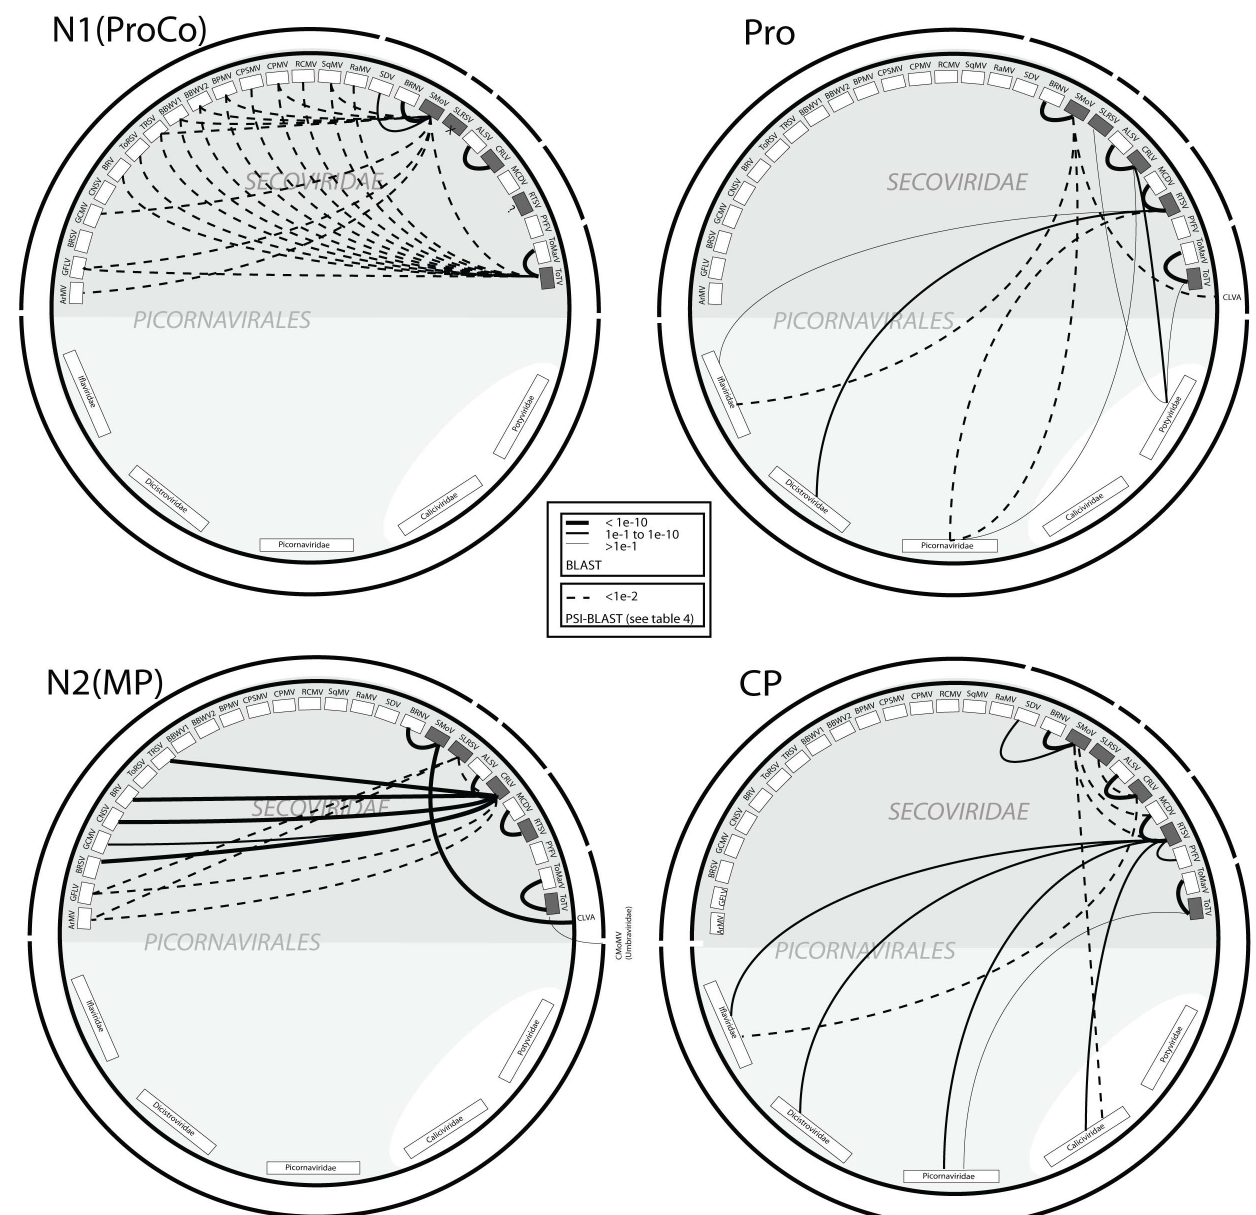
Figure 5. Schematics of the amino acid similarities four functional domains of members of the Secoviridae . These proteins are: on RNA1 (a), the putative protease cofactor or 1N terminal protein 1N(ProCo), the protease (Pro), and on RNA2 (b) the putative movement protein or 2N terminal protein 2N(MP), and the coat protein (CP). The analyzed proteins are those from five lineages of secovirids, the species Apple latent spherical virus (ALSV), Arabis mosaic virus (ArMV), Bean pod mottle virus (BPMV), Beet ringspot virus (BRSV), Black raspberry necrosis virus (BRNV), Blackcurrant reversion virus (BRV), Broad bean wilt virus-1 (BBWV1), Broad bean wilt virus-2 (BBWV2), Cherry rasp leaf virus (CRLV), Cowpea mosaic virus (CPMV), Cowpea severe mosaic virus (CPSMV), Cycas necrotic stunt virus (CNSV), Grapevine chrome mosaic (GCMV), Grapevine fanleaf virus (GFLV), Maize chlorotic dwarf virus (MCDV), Parsnip yellow fleck virus (PYFV), Radish mosaic virus (RaMV), Red clover mottle virus (RCMV), Rice tungro spherical virus (RTSV), Satsuma dwarf virus (SDV), Squash mosaic virus ( SqMV), Strawberry mottle virus (SMoV), Strawberry latent ringspot virus (SLRSV), Tobacco ringspot virus (TRSV), Tomato marchitez virus (ToMarV) and Tomato ringspot virus (ToRSV), Tomato torrado virus (ToTV). In the lower light gray shaded hemisphere are the animal infecting families of the order Picornavirales, which excludes the picorna-like virus families Caliciviridae and Potyviridae. The outer broken black circle shows the clustering of related viruses in different secovirus lineages. Similarities were determined using the BLAST and PSI-BLAST algorithms; details of the PSI-BLAST are listed in table 4. Viruses depicted were selected based on the highest scoring sequence for each species (within the Secoviridae) or family (among the picorna-like viruses) with only one sequence hit being shown irrespective of the number identified by the program. Secovirids not included in primary analysis were only marked on the figure when they were the only representative that was a hit. For each taxon shown, Blast hits are depicted in favor of PSI-BLAST hits, PSI-BLAST hits only being shown in the absence of a Blast hit.